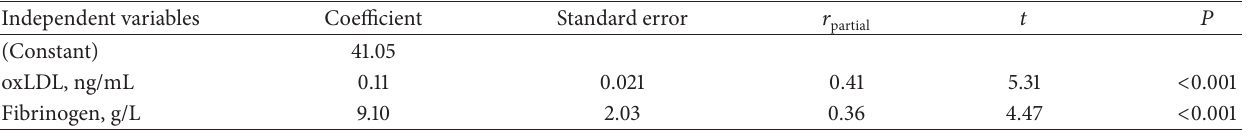
Table 5: Multivariate regression, dependent variable